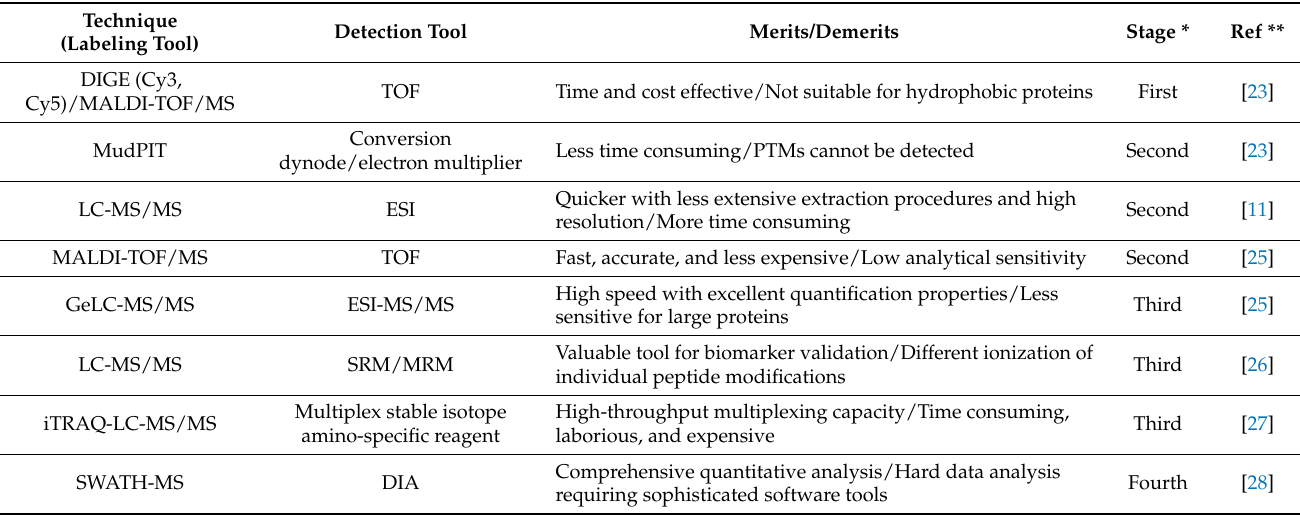
Table 1. Different techniques used in crop